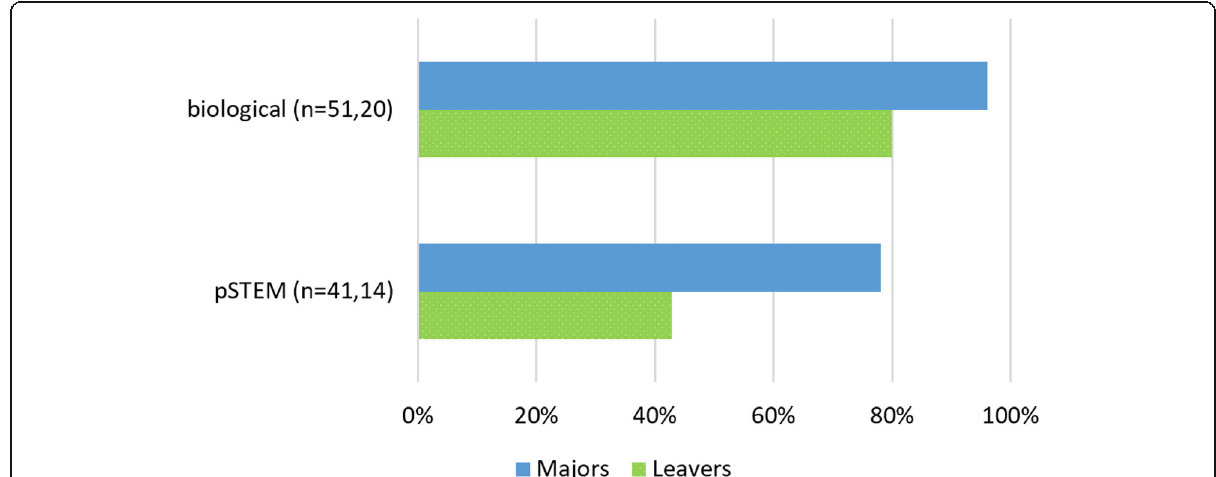
Fig. 3 Perception of professor care by field, biological sciences, and physics sciences